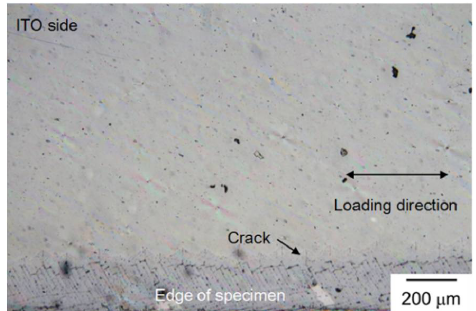
Figure 6. OM micrographs of ITO/PEN sheet after tensile bending with a 10 mm curvature radius for 1000 h: ( a ) viewed from PEN side; ( b ) viewed from ITO side.